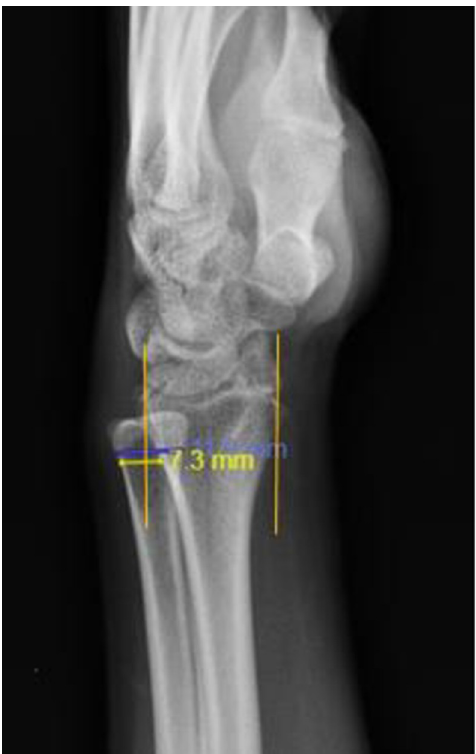
Fig 1. A line is drawn through both the volar and dorsal margins of the distal radius which is extended through the ulnar head. Instability is present when more than 25% of the head of the ulna lies volar or dorsal to these lines. Plain radiograph of Mr. M (Study subject) showing dorsal subluxation of the DRUJ using the Mino Method. 7.3mm/ 11.9mm x 100% =